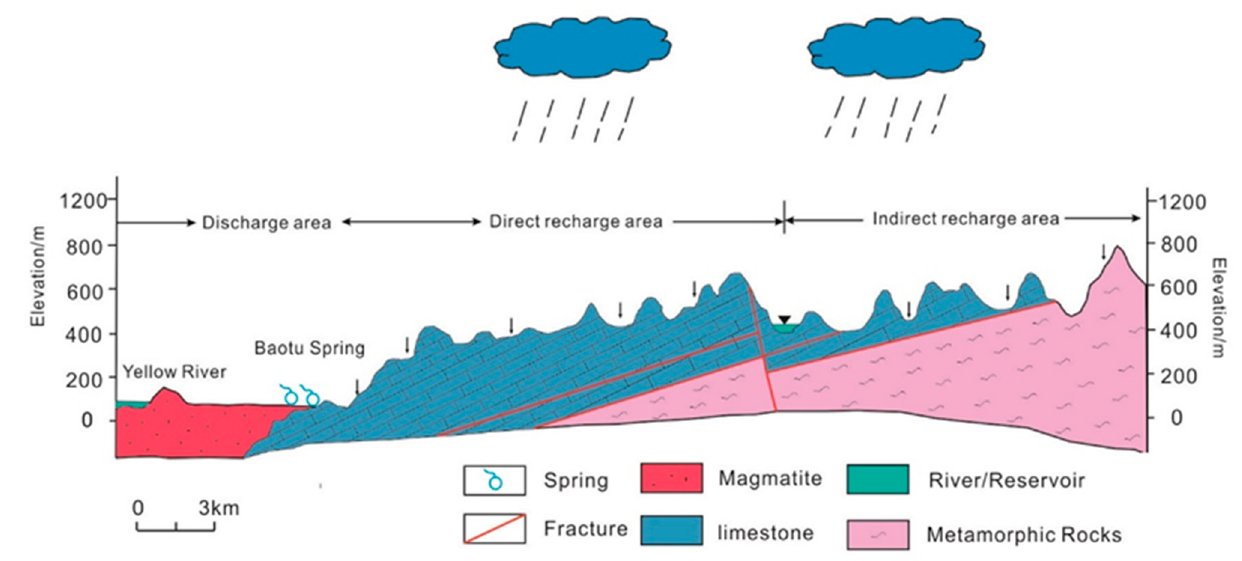
Figure 3. The cause of the formation of the springs in Jinan [24].